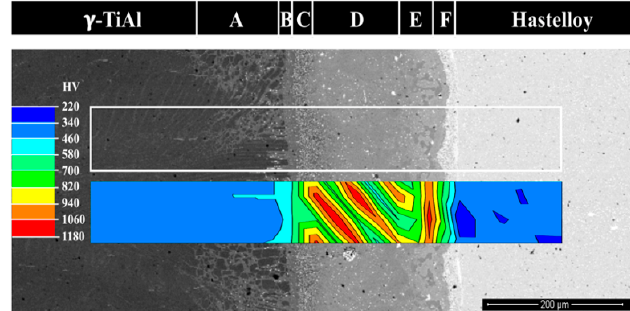
Figure 9. BEI and hardness distribution map of the interface produced at 980 °C.